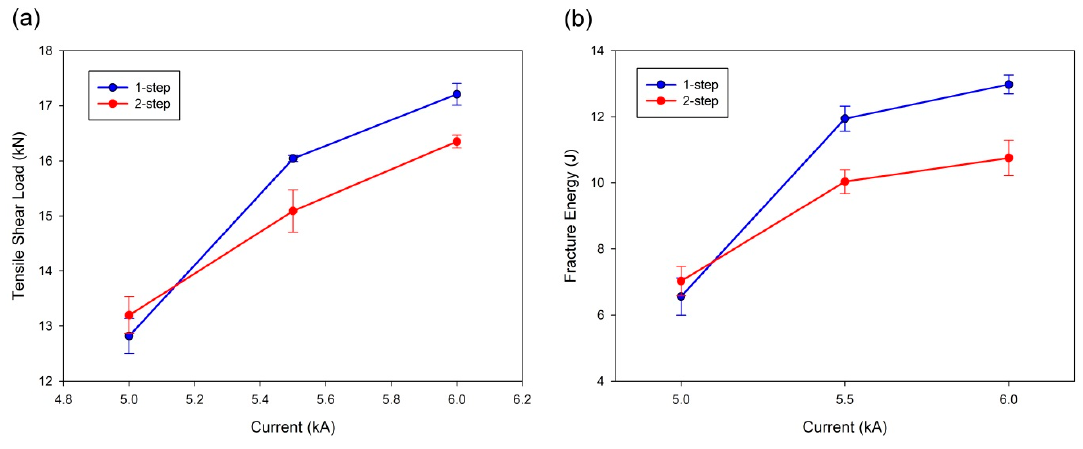
Figure 5. Mechanical properties of one-step and two-step RSW specimens: ( a ) Tensile shear load; ( b ) fracture energy.